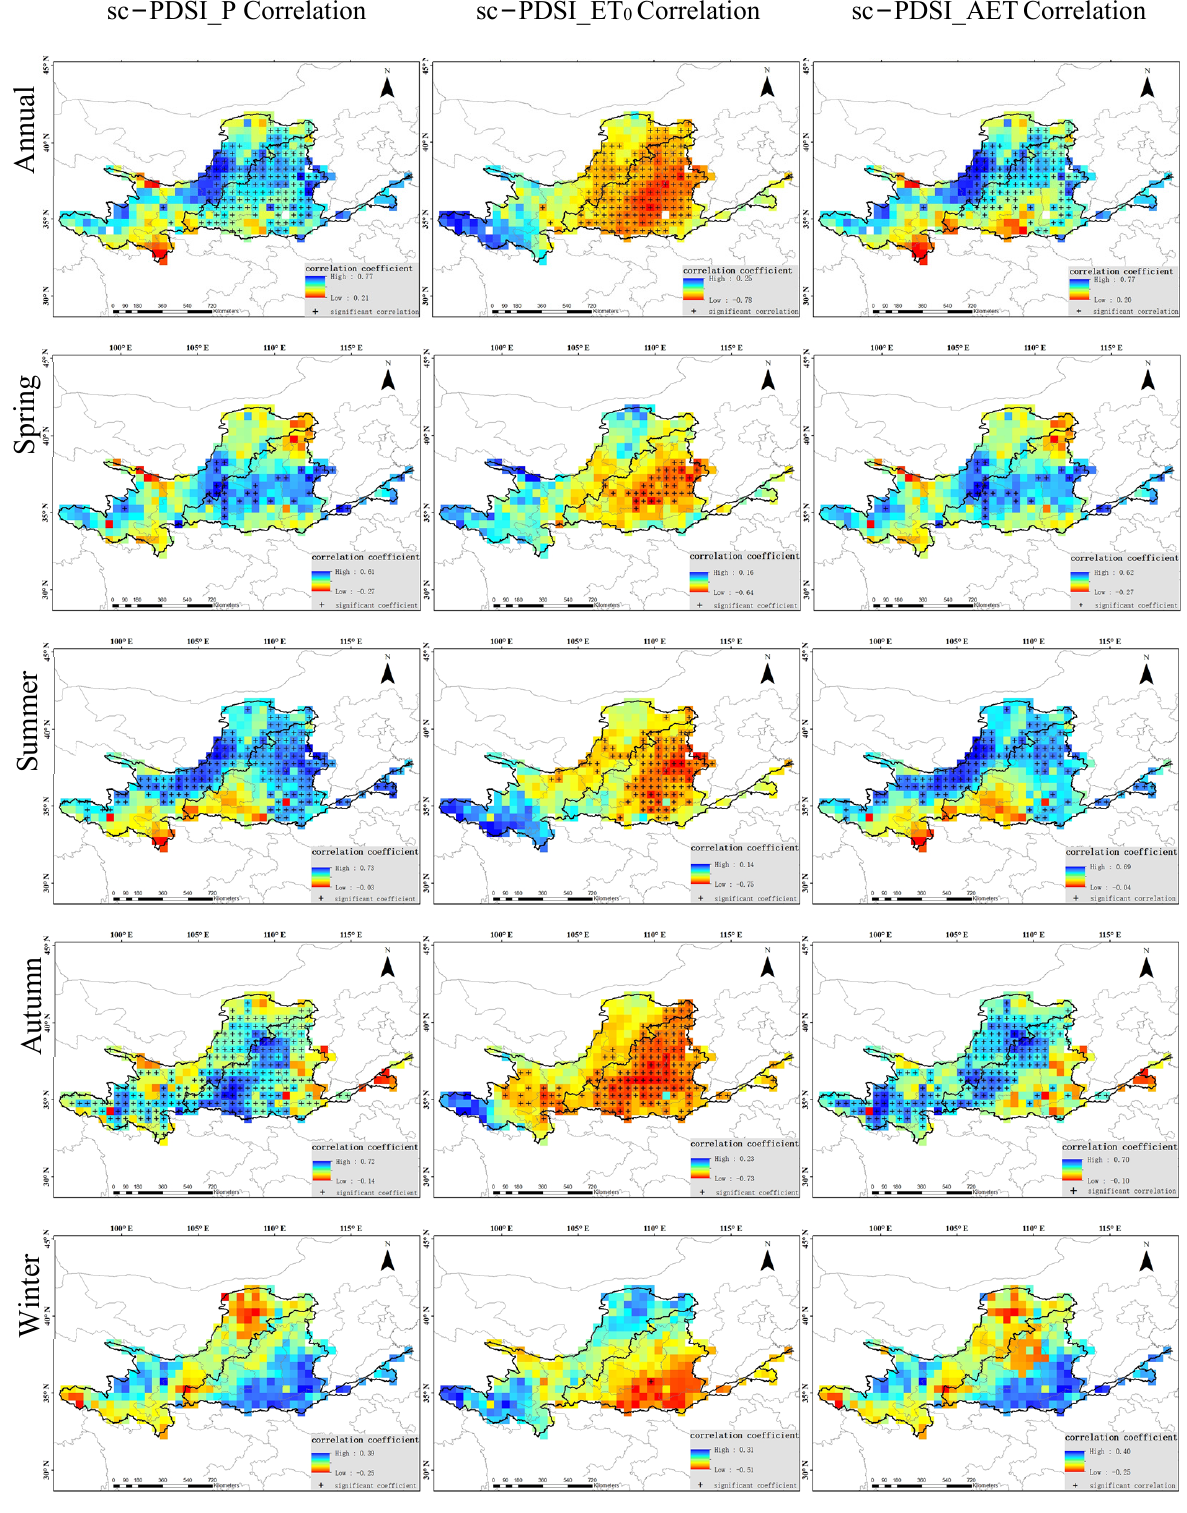
Figure 7. Spatial distribution of correlation coefficient between sc-PDSI and P, ET 0 , AET in annual, spring, summer, autumn, and winter from 1951 to